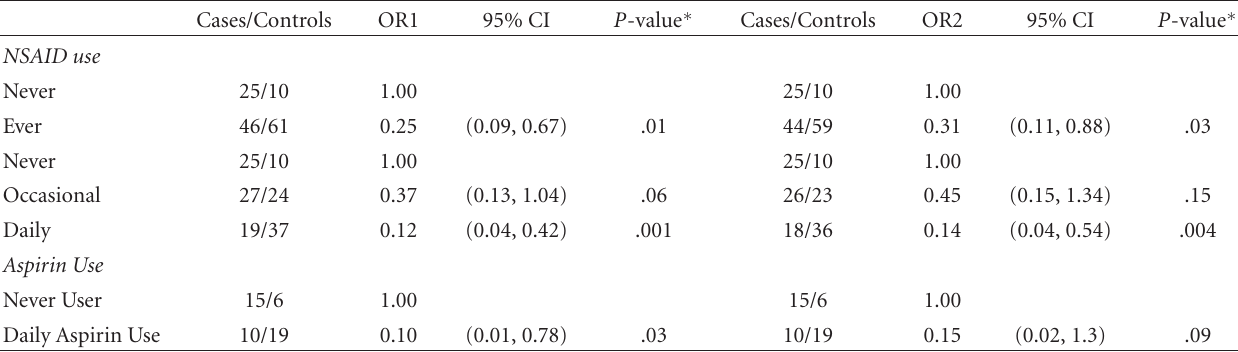
Table 3: Unadjusted and Adjusted risk estimated of having Head and Neck Cancer by NSAID use